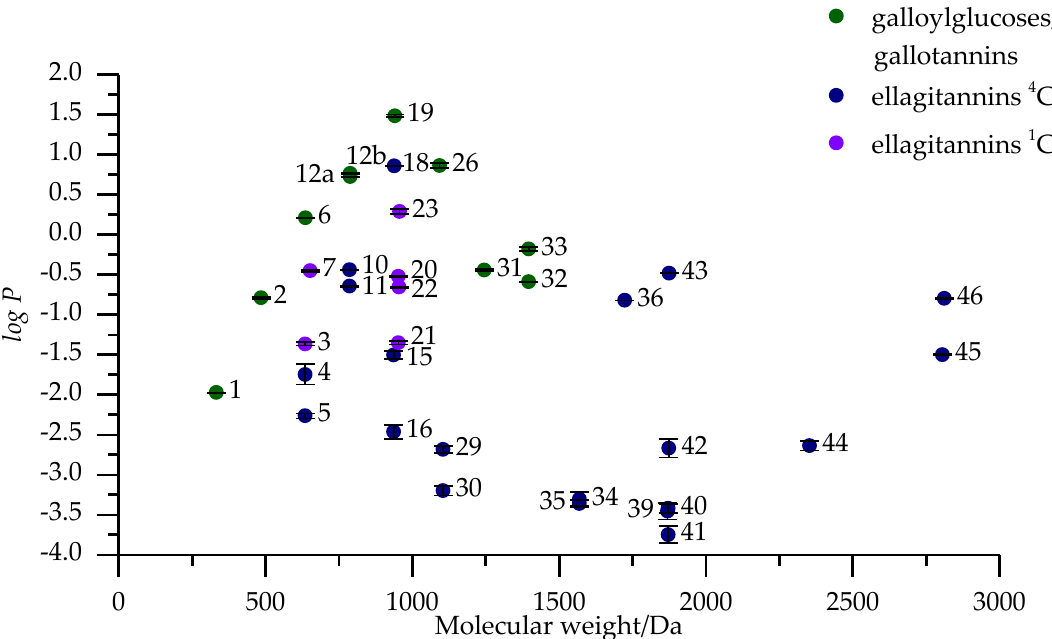
Figure 3. LogP values of 47 hydrolysable tannins plotted against their molecular weights measured with UPLC showing galloylglucoses / gallotannins, 4 C 1 glucose core ellagitannins and 1 C 4 glucose core ellagitannins in different series. The numbers refer to Figures 1 and 2 and Table A1.